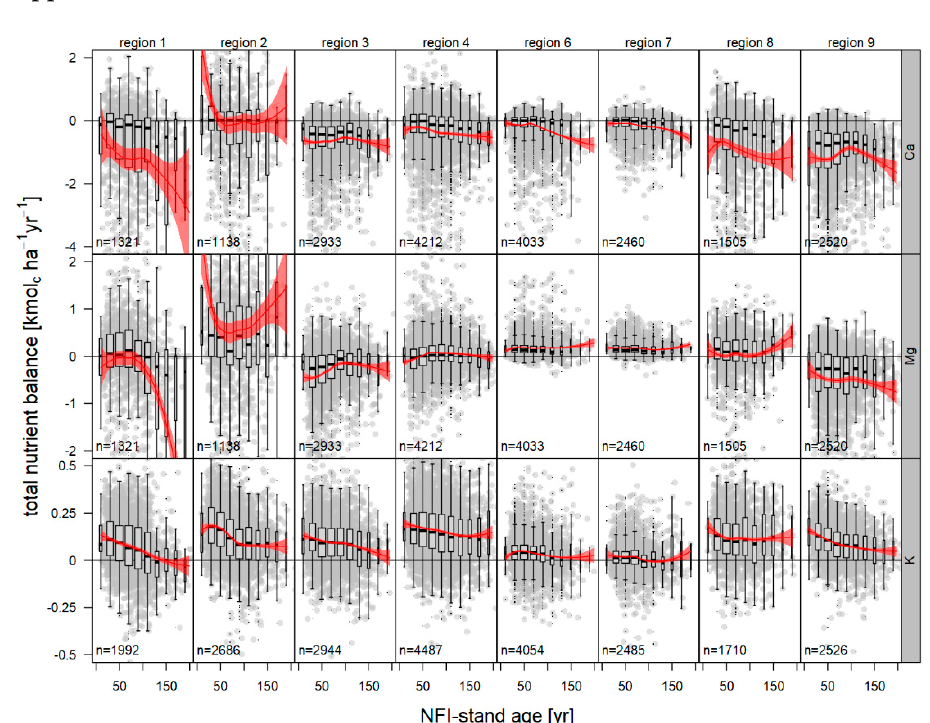
Figure A3. Nutrient balance (weathering + deposition—leaching—harvesting removal + soil stock/1000 [scenario REAL]) at NFI tracts over mean stand age at time NFI 2012, stratified by model regions (see Figure 2), for calcium (Ca) and magnesium (Mg) only on carbonate-free soils. Boxplots for age classes of 20 years; the width of the box is proportional to the number of tract corners in the age class; y-axis restricted to 90% of the data, but the data basis for the loess curve (red) is not. 1—pre-alpine moraines and limestone Alps; 2—hills on limestone bedrocks; 3—hills on crystalline bedrocks; 4—hills on sand, silt, clay bedrocks; 6—old moraines, north German lowland; 7—young moraines, north German lowland; 8—loess regions, fluvial valleys; 9—hills on clay- and silt schist bedrocks. Note: the number 5 was deliberately not assigned.